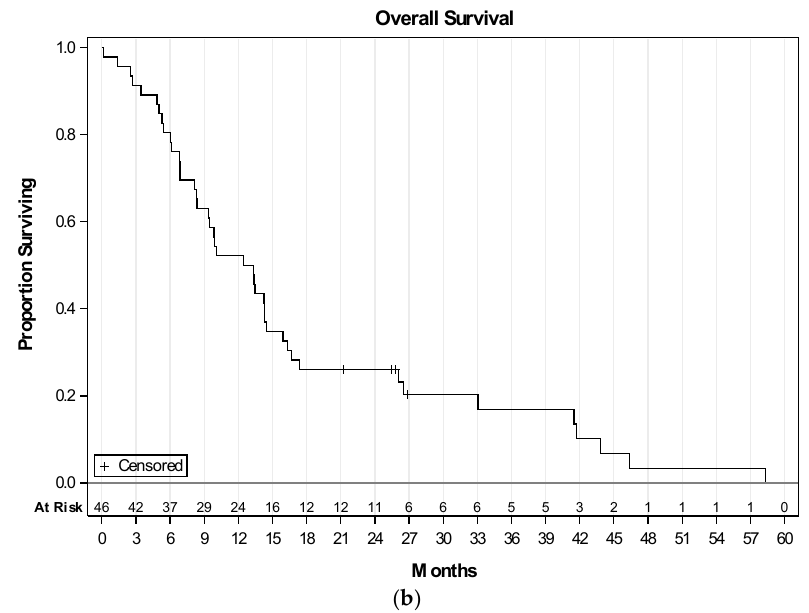
Figure 3. ( a ) Progression-free survival (PFS) in 46 treated patients. Median PFS: 5.7 months (95% CI: 2.1–8.0). PFS was calculated from date of study treatment initiation to progression or death from any cause. Patients removed due to toxicity were censored at date of removal; ( b ) overall survival (OS) in 46 treated patients. Median OS: 12.9 months (95% CI: 8.3–14.5). Patients removed due to toxicity were censored at date of removal.